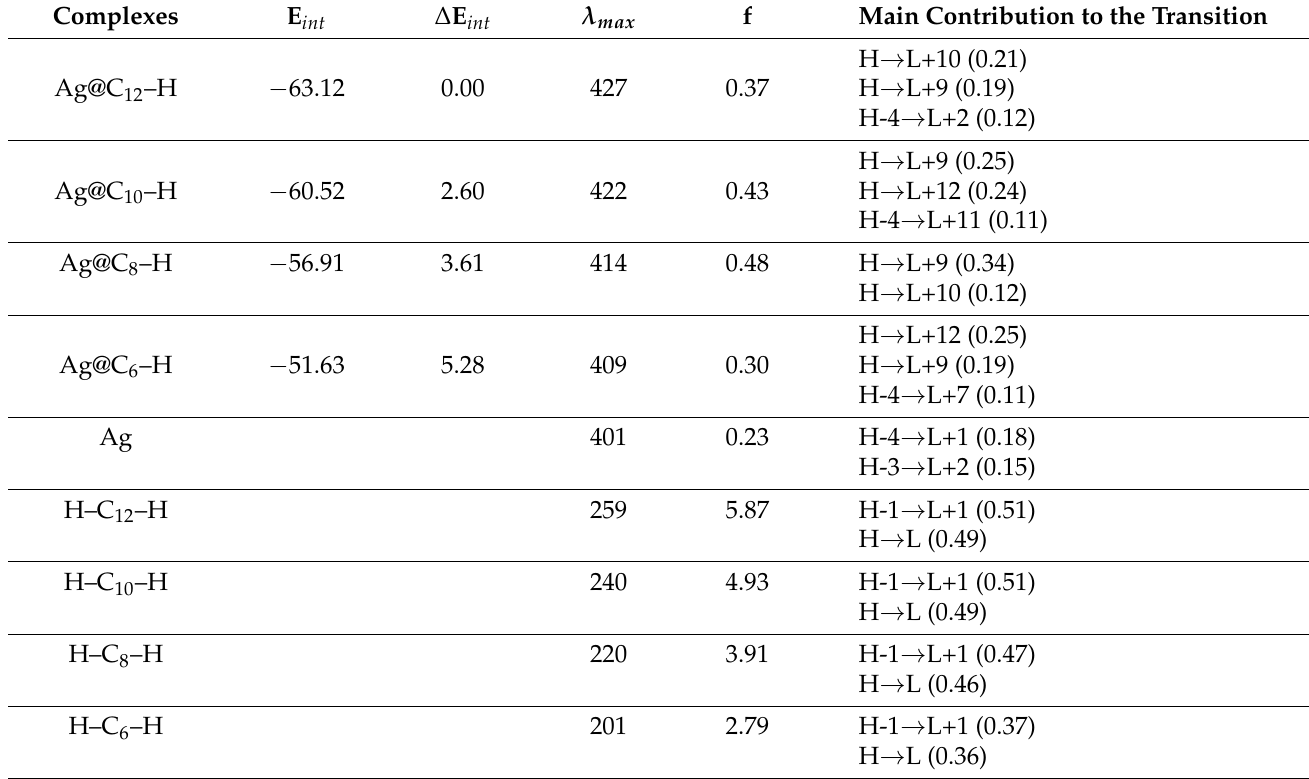
Table 2. Interaction energies (kcal · mol − 1 ), E int = E Ag @ C wavelength (nm), oscillator strength, and main contributions to the transitions of Ag@C 2 n